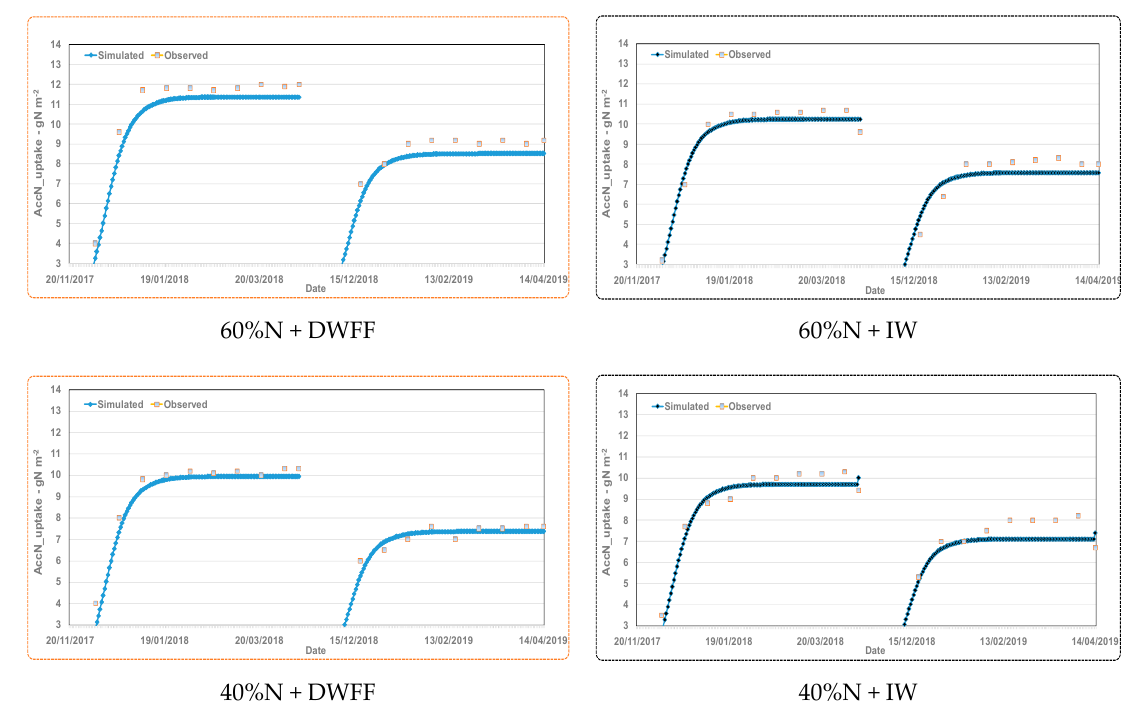
Figure 12. Observed and simulated accumulated-nitrogenuptake during 2017/2018 and 2018/2019 for all treatments: drainage water from fish farms(DWFF), fresh irrigation water (IW) and nitrogen (N).